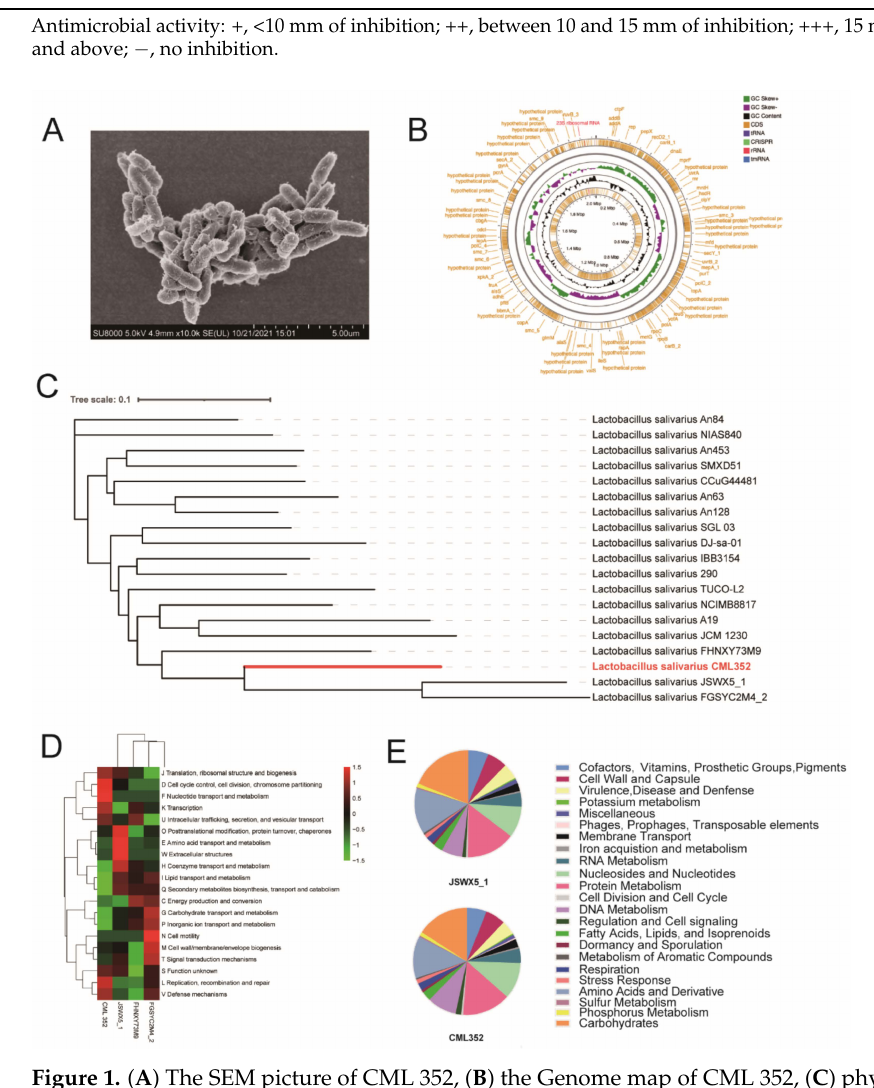
Figure 1. ( A ) The SEM picture of CML 352, ( B ) the Genome map of CML 352, ( C ) phylogenetic tree of CML 352, ( D ) the clusters of orthologous groups (COG) repertoires, ( E ) the subsystem category distribution of JSWX5_1 and CML